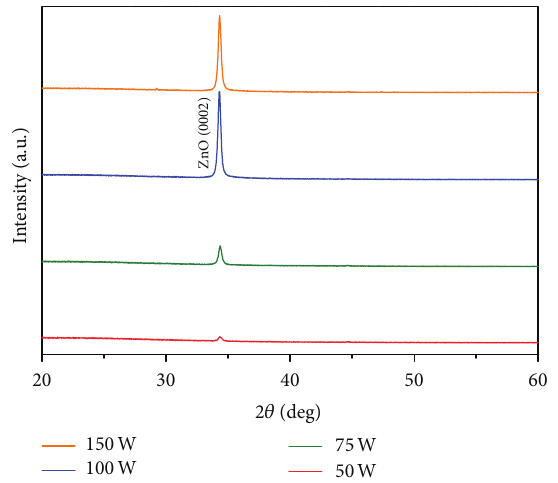
Figure 1: XRD patterns for the ZnO thin films deposited onto glass substrates at room temperature with RF deposition powers in the range of 50, 75, 100, and 150W at a fixed deposition time of 30 mins,